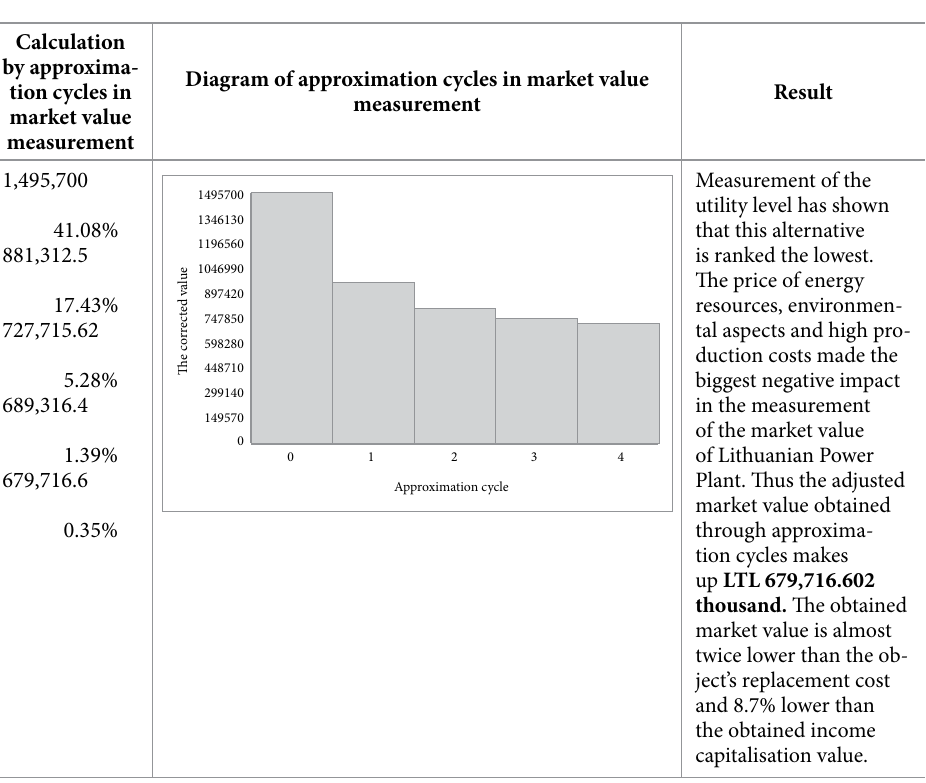
table 10. The result of market value measurement for the Geothermal Power Plant calculation by approxima­ tion cycles in market value